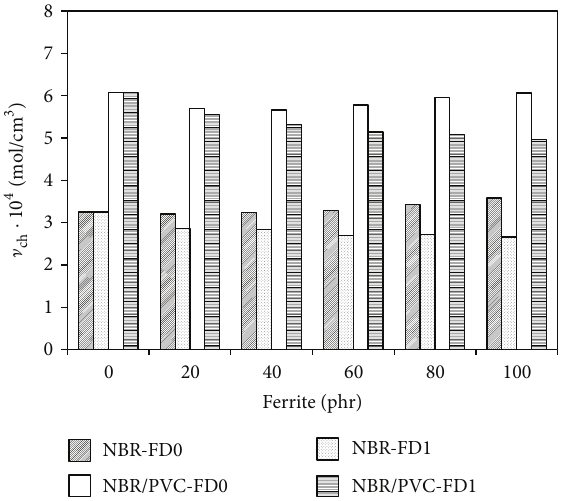
Figure 2: Influence of ferrites content on optimum cure time 𝑡 𝐶90 of rubber compounds.